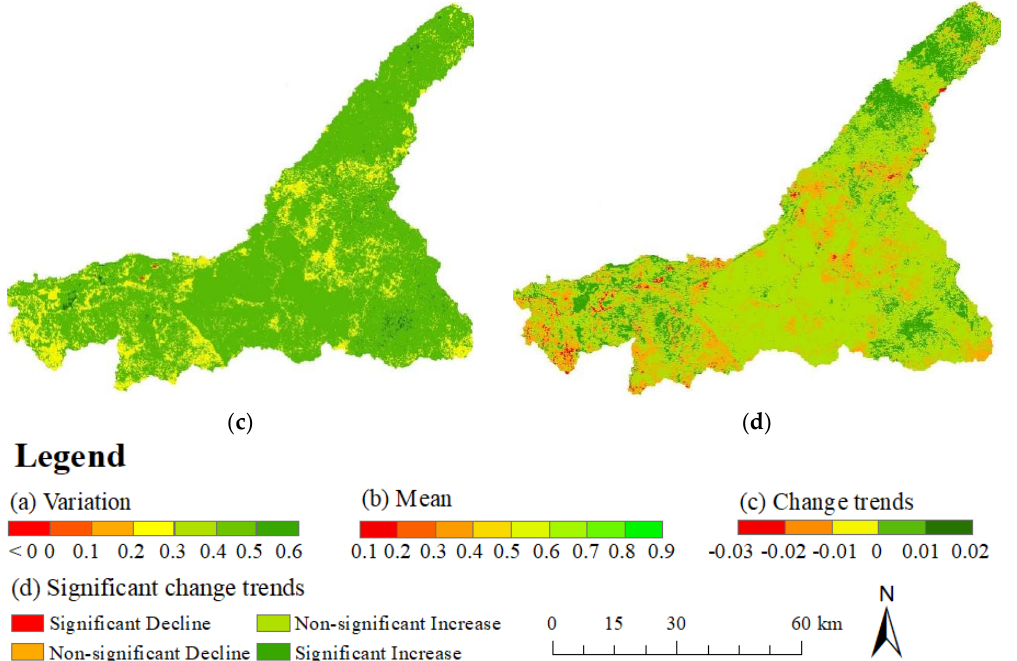
Figure 5. Spatial distribution of VGT in dry seasons in Mara River Basin: ( a ) NDVI variation in dry seasons; ( b ) average NDVI in dry seasons; ( c ) NDVI change trends in dry seasons ( S -value); ( d ) NDVI significant change trends in dry seasons ( Z -value). Table 1. Proportion of area with different VG trends